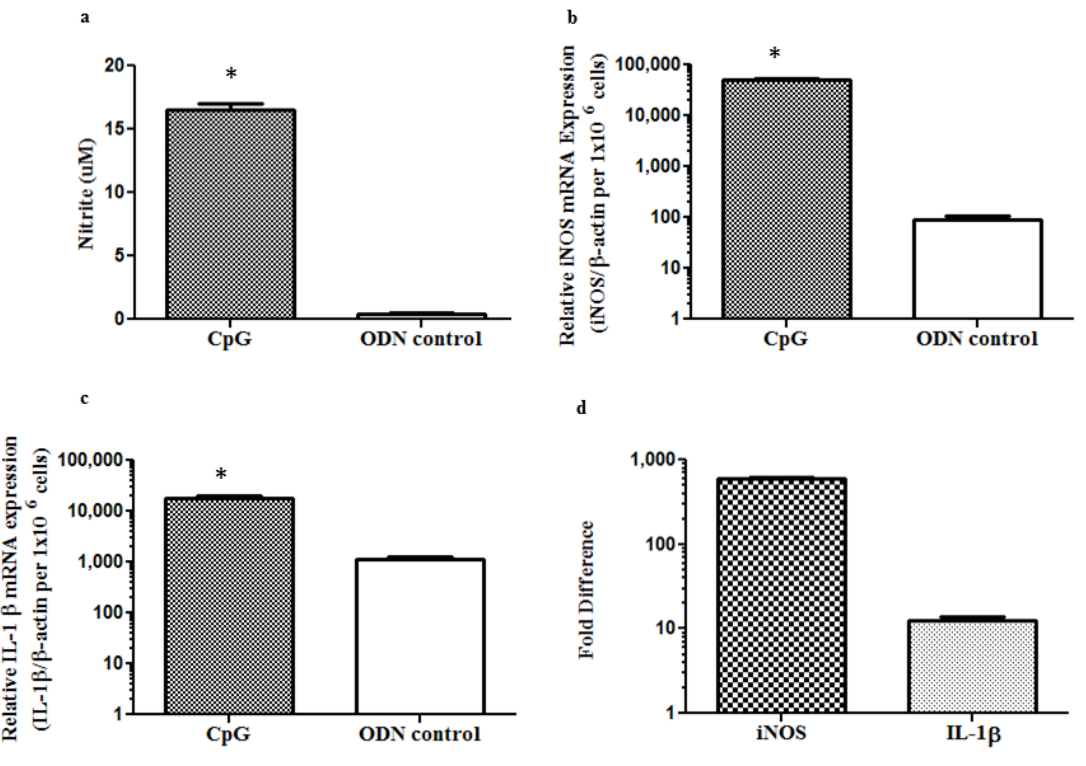
Figure 3. Stimulation of primary chicken macrophages in vitro with CpG DNA up regulates mRNA expression of pro-inflammatory mediators and increases NO production. Blood derived macrophages (1.5 × 10 6 cells per well) were stimulated with 10 μM of CpG DNA in phenol red free complete RPMI 1640 without antibiotics and same concentration non-CpG DNA treatment was used as control for the determination of NO ( a ) and the mRNA expression of iNOS ( b ) and IL-1β ( c ) at 12 h post-stimulation; ( d ) represents the fold difference in iNOS and IL-1 β expressions by CpG DNA treated macrophage cells when compared to non-CpG DNA treated group. Differences between groups were analyzed using student’s t -test. * = significant at p ≤ 0.05 when student’s t -test was